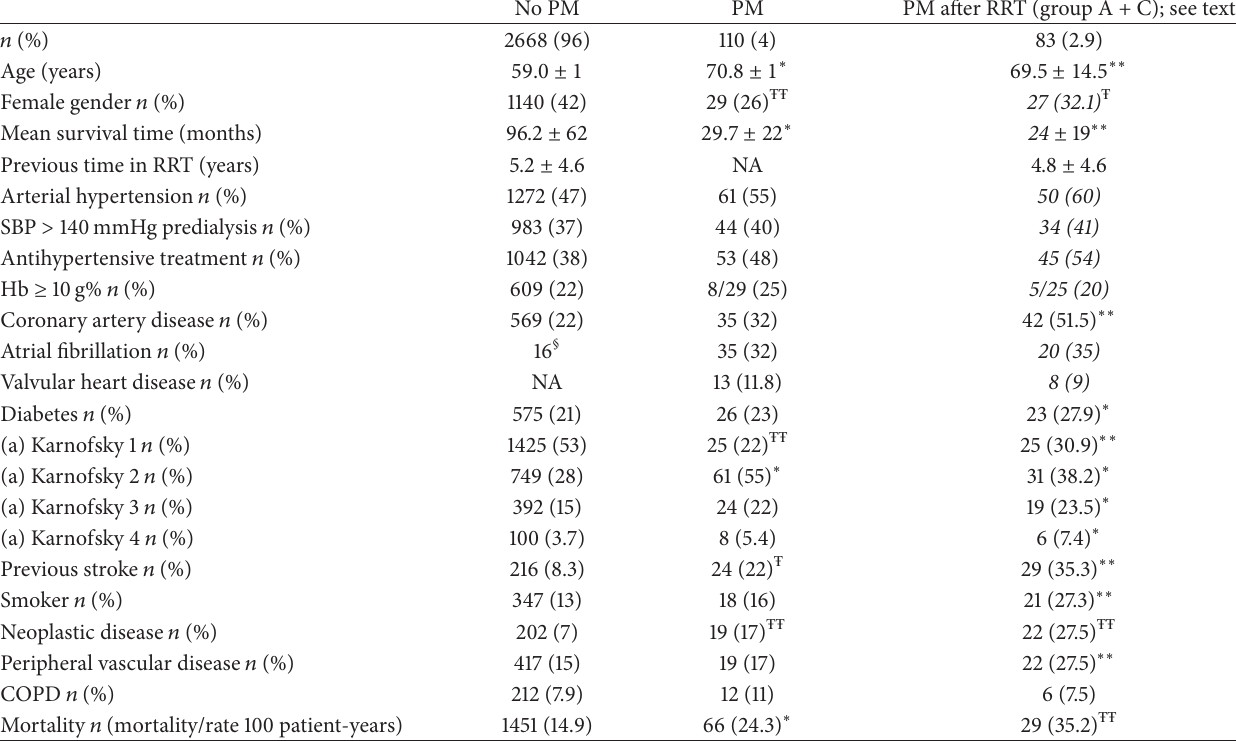
Table 1: Patient demographics.